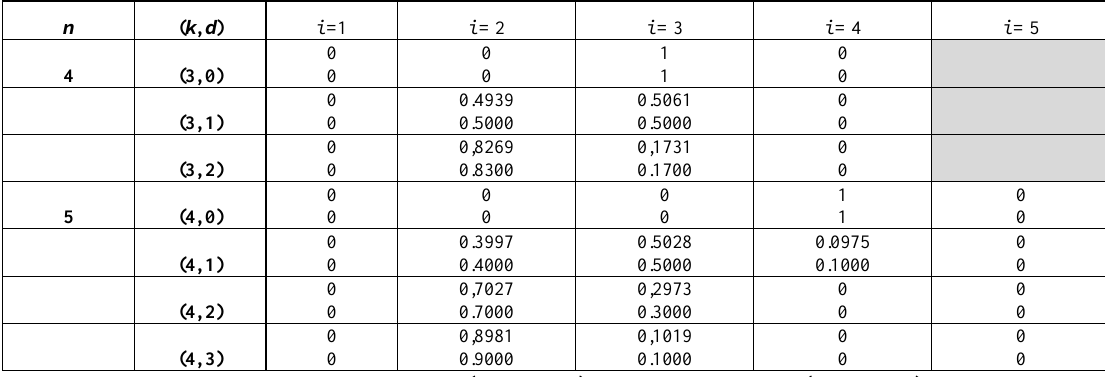
Table 1. Exact and simulation-based signatures of the constrained ( k , d ) − out − of − n : F structure.